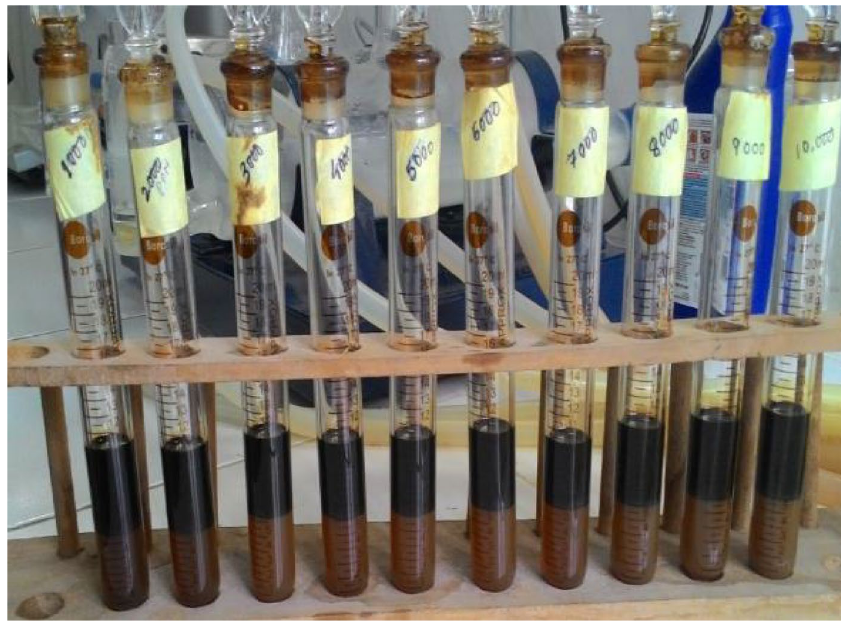
Fig. 7 Phase behavior analysis of crude with